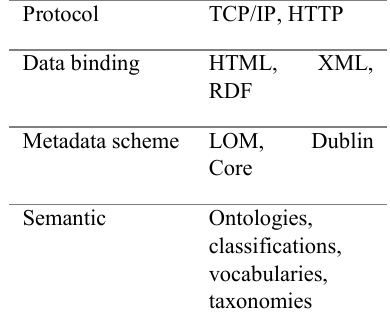
Table 1. Layers of interoperability ( Source: Duval 2001